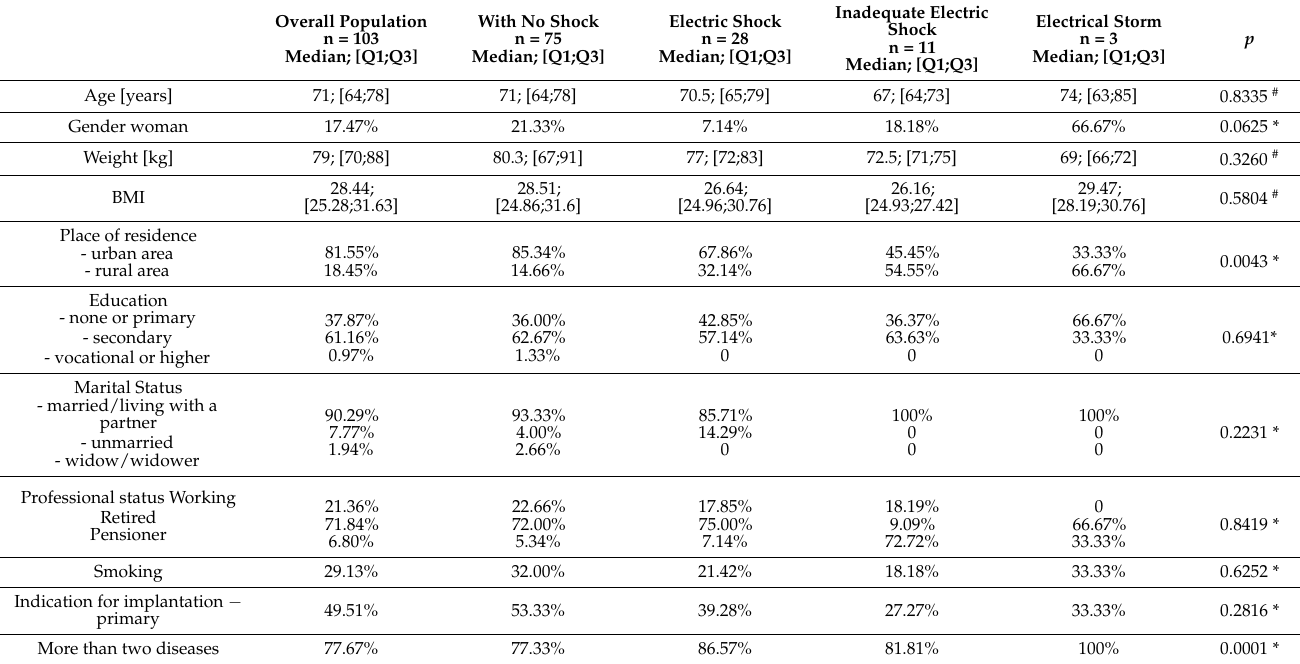
Table 1. The characteristics of the elderly patients included in the study, including the endpoints.